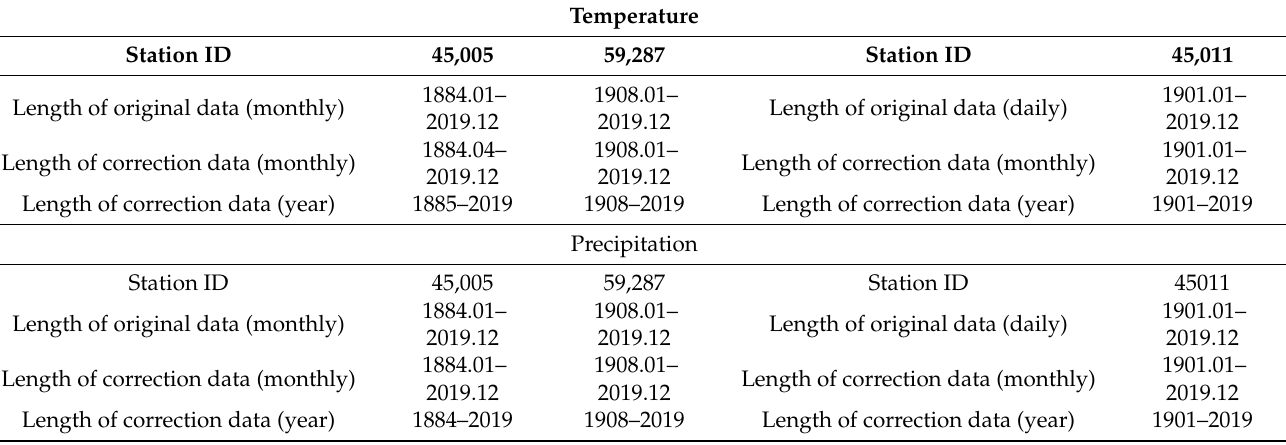
Table 3. Data processing information of the representative stations in The Guangdong–Hong Kong– Macao Greater Bay